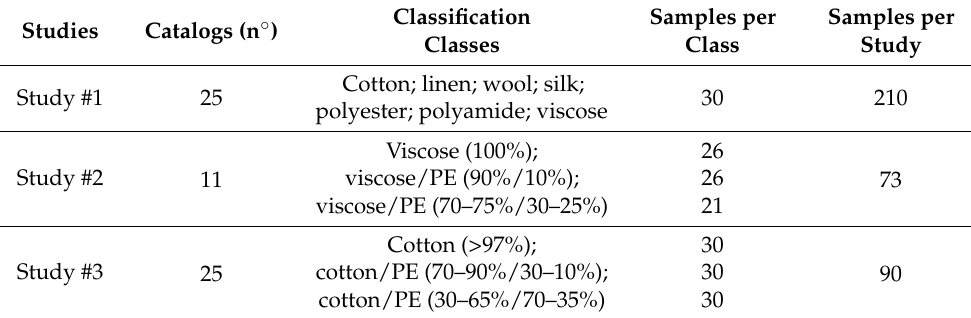
Table 1. Origin and number of samples used in each